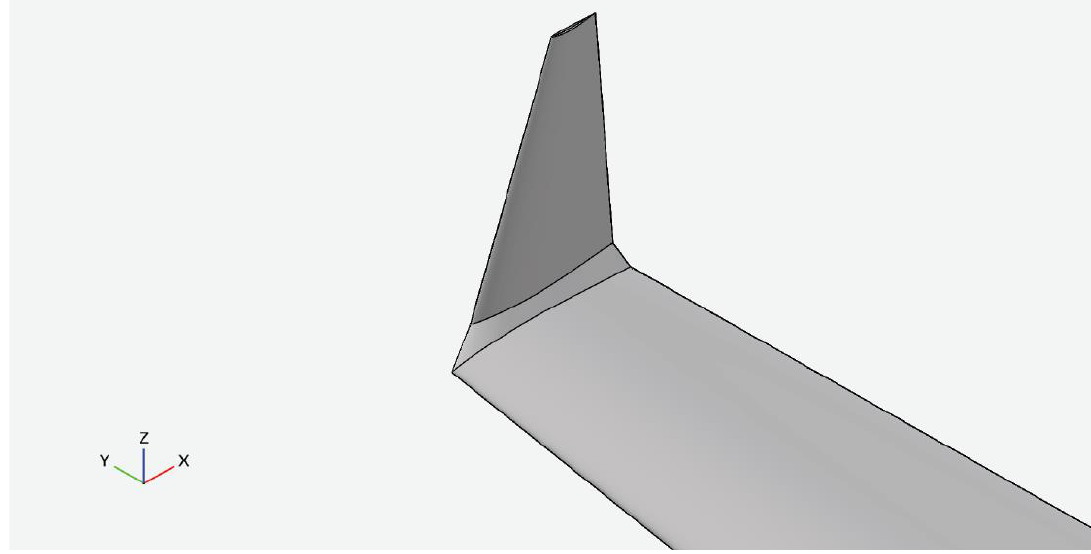
Figure 13. Isometric view of the optimal winglet.